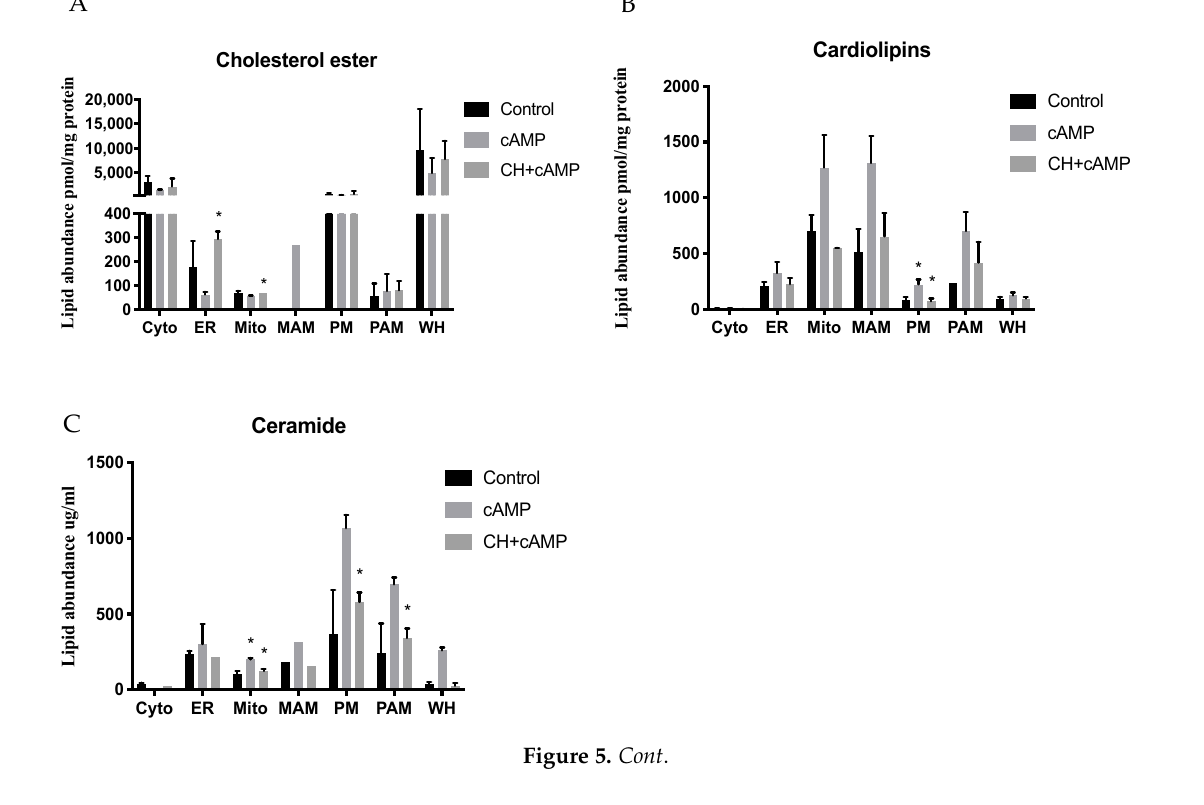
Figure 5. Cholesteryl ester, cardiolipin, and ceramide distribution profiles in subcellular fractions. ( A ) Cholesteryl ester, ( B ) cardiolipin, and ( C ) ceramide abundance in cytosol (Cyto), endoplasmic reticulum (ER), mitochondria (Mito), mito- chondria-associated membrane (MAM), plasma membrane (PM), and plasma membrane-associated membrane (PAM) fractions, as well as whole cell extract (WC) from control, dbcAMP-treated, and dbcAMP plus cycloheximide-treated MA- 10 cells. ( D ) Heat map analysis showing changes in ceramide (Cer) levels in response to stimulation with dbcAMP and dbcAMP plus cycloheximide in MA-10 cells. Acyl groups are abbreviated by the number of carbon atoms and double